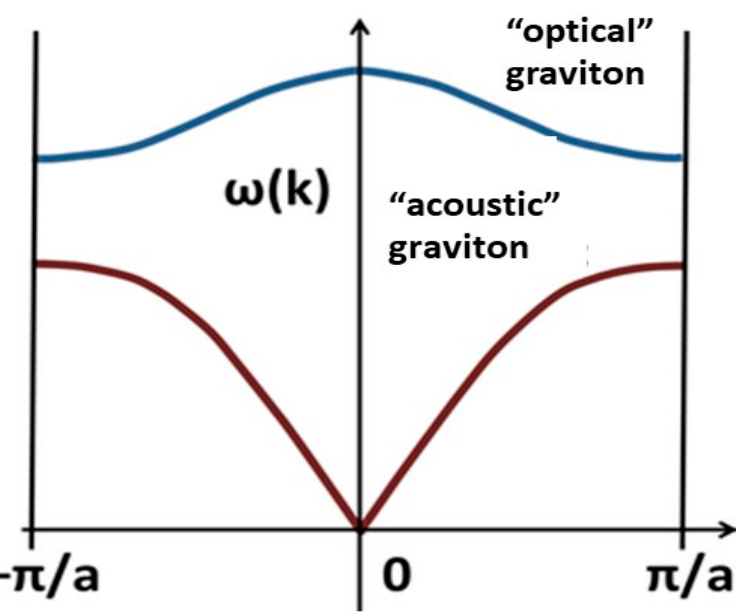
Figure 2. Dispersion curves of “acoustic” and “optical” gravitons.